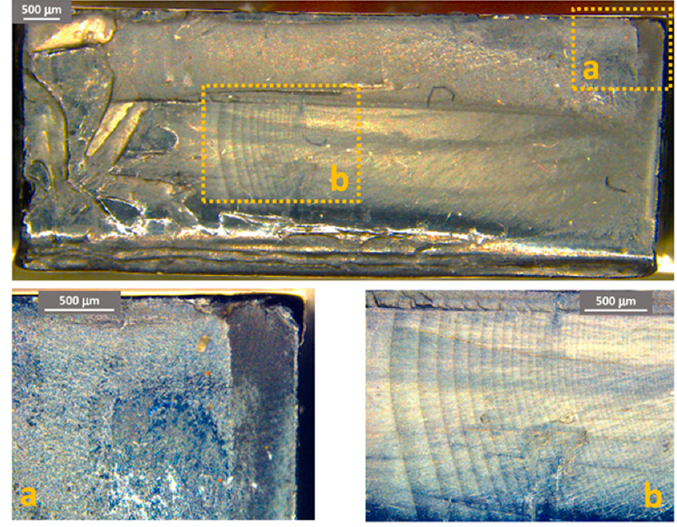
Figure 16. ABS fracture surface after test at − 27 °C. ( a ) Crack initiation point; ( b ) propagation beach marks.